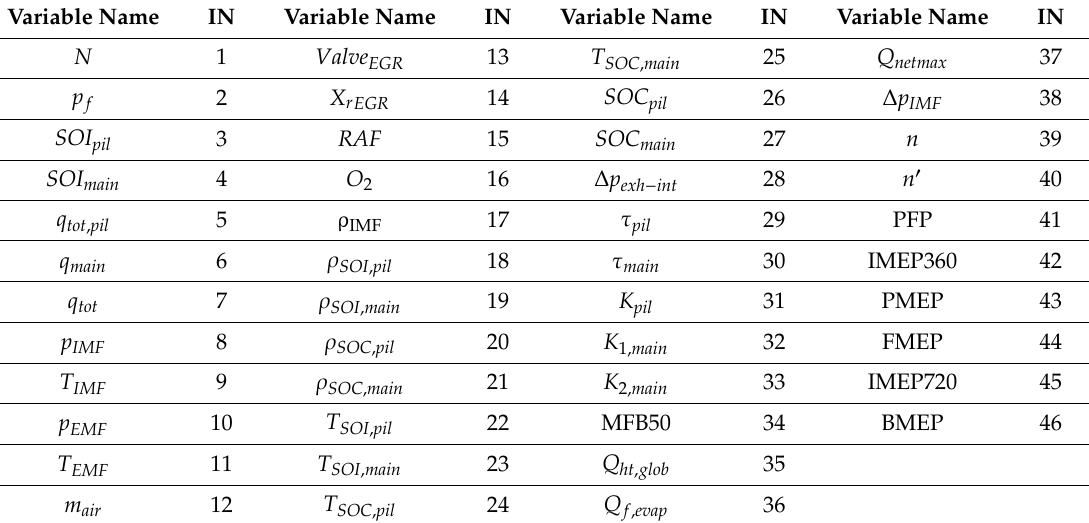
Table A1. Collected variables and corresponding index number (IN).